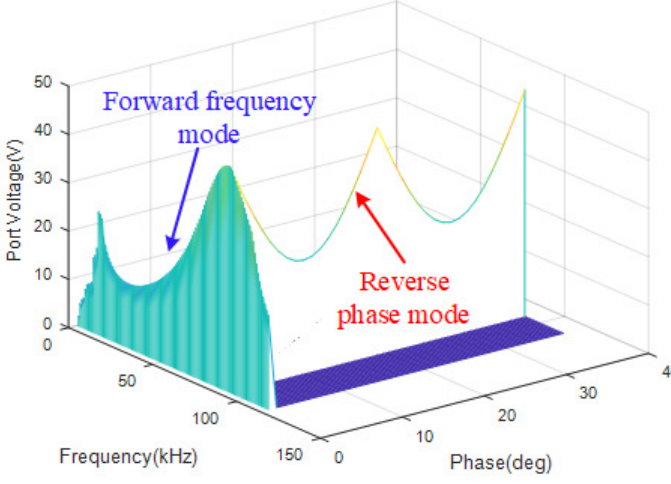
Figure 13. System working